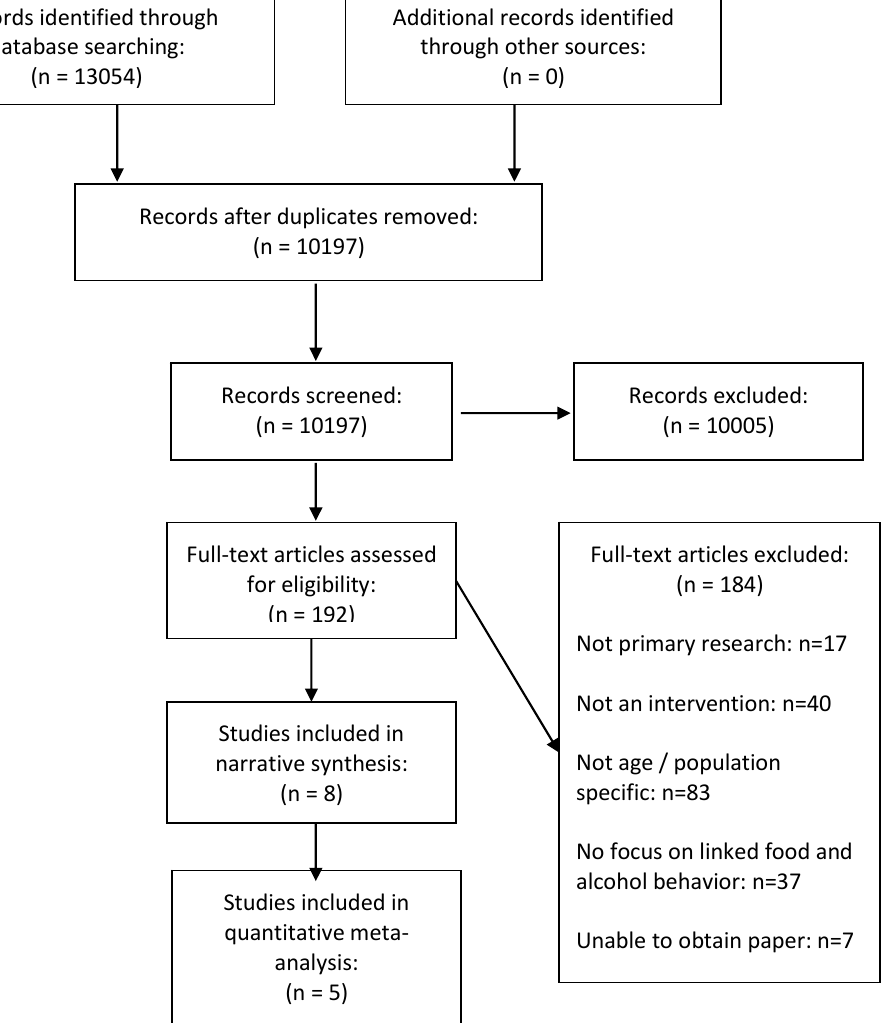
Figure 1. Flow chart showing study selection process.